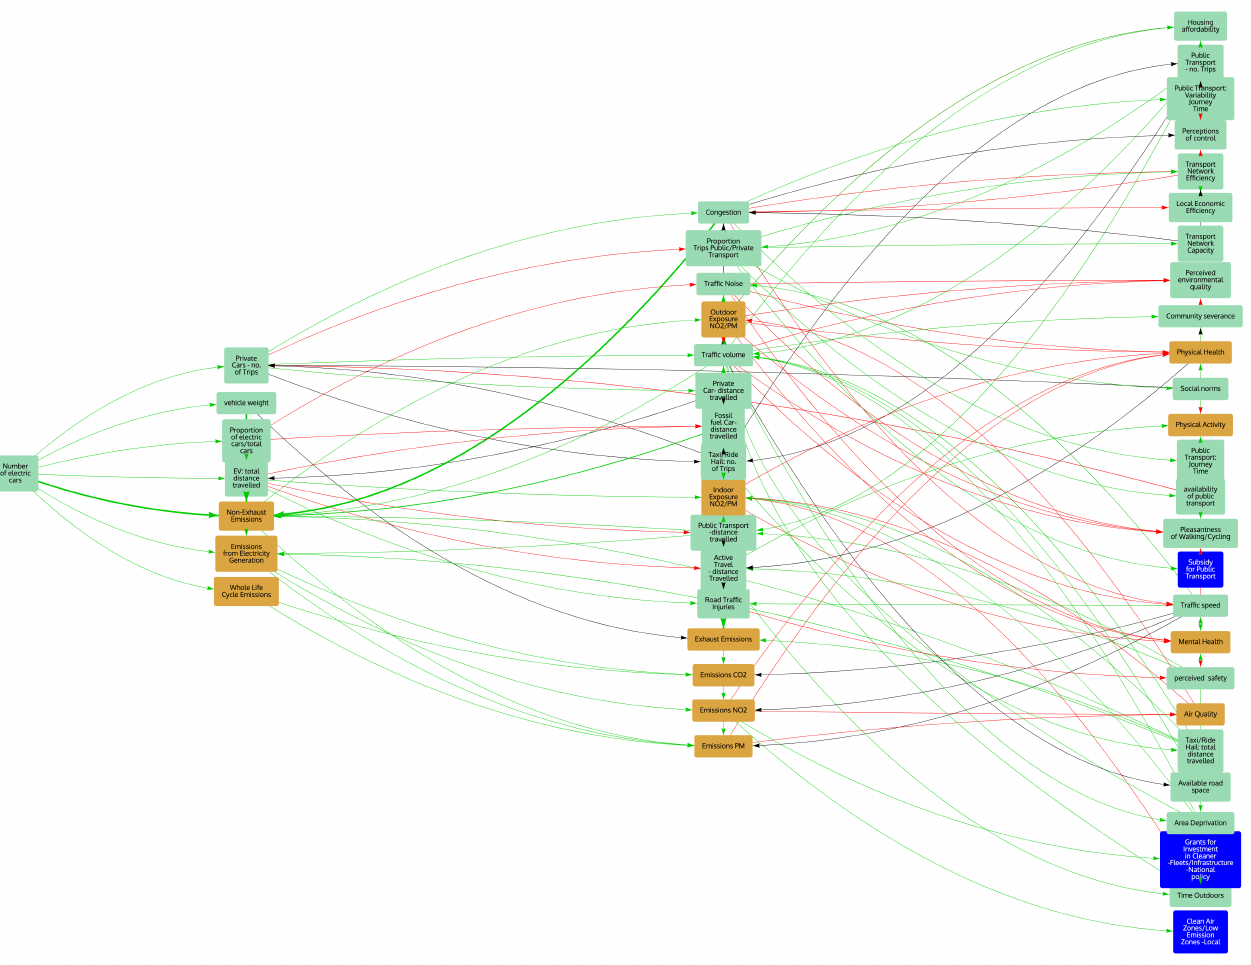
Figure 3. Number of electric cars: downstream 3